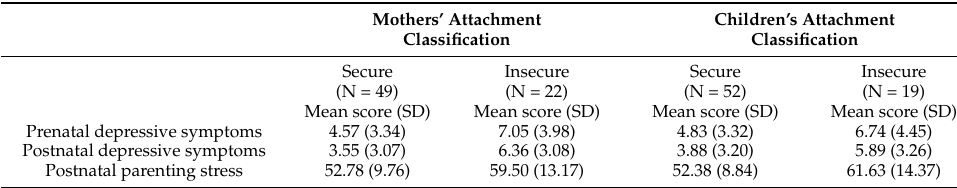
Table 3. Means and standard deviations for EPDS and PSI-SF scores.